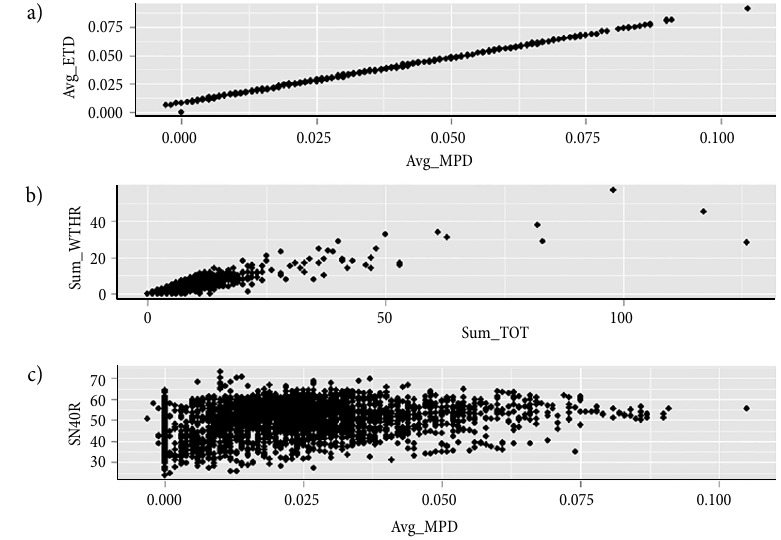
Fig. 4. Scatterplots of crashes and pavement friction characteristics